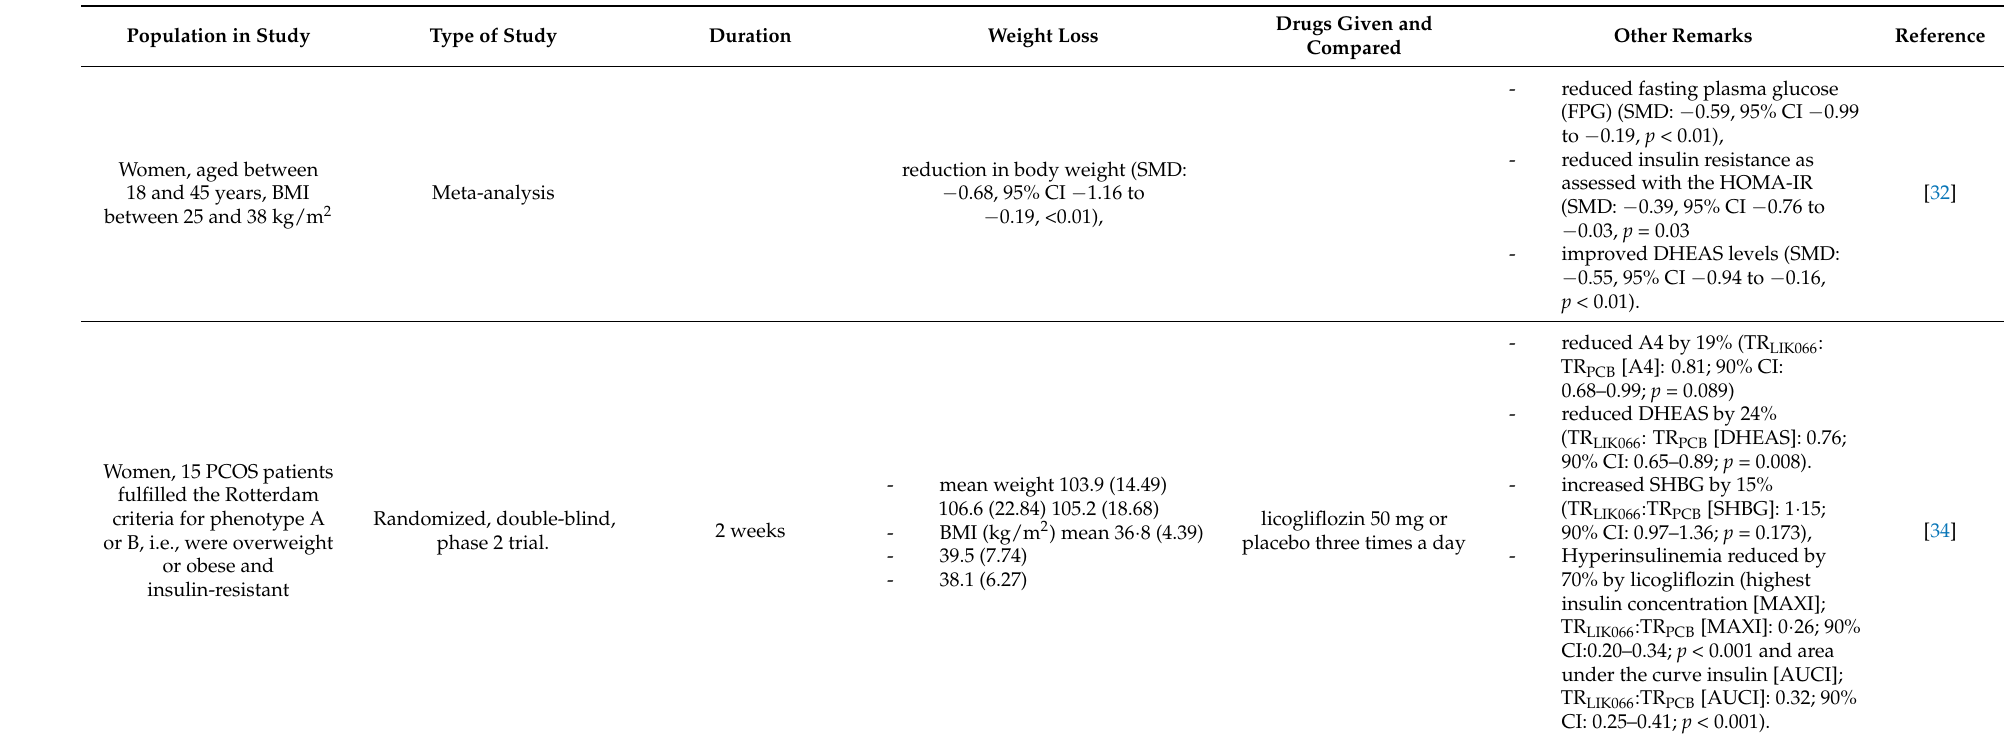
Table 2. The effects of SGLT-2is on different parameters from preclinical and clinical